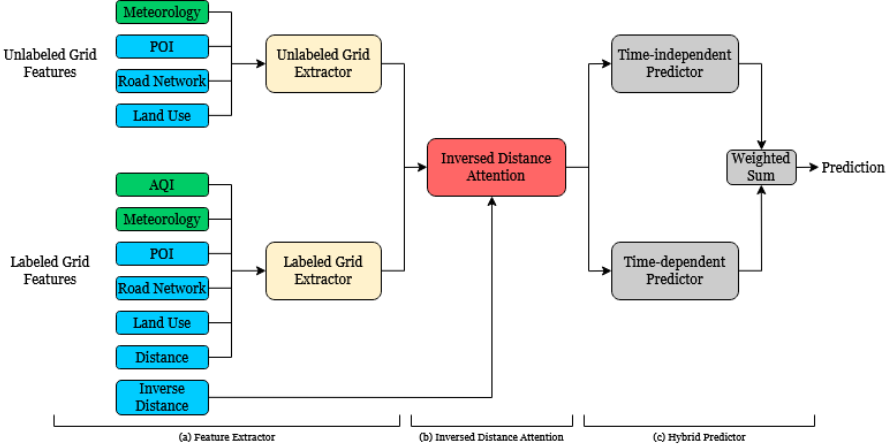
Figure 1. The overall architecture of our proposed model. ( a ) Our feature extractors for processing grid-based features. The color green represents dynamic features. The color blue represents static features. The color cream represents grid extractors. ( b ) The inversed distance attention (color red) calculates the influences of labeled grids on unlabeled target grids. ( c ) Our proposed hybrid predictor(color grey) makes the final